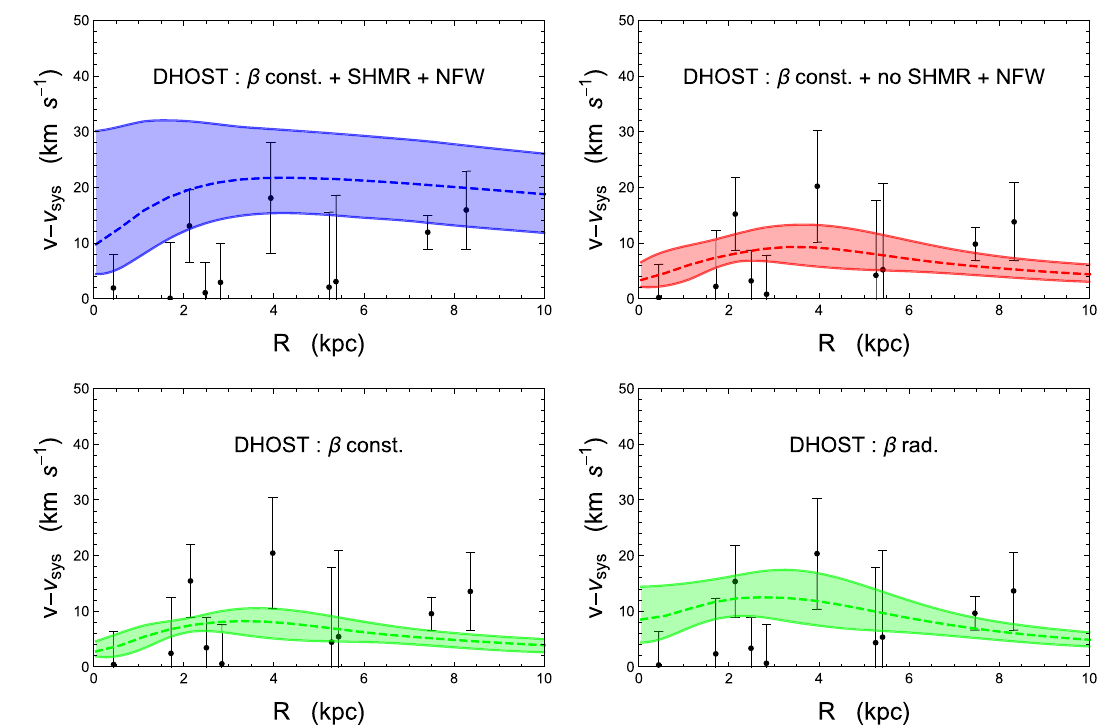
Fig. 3 Velocity offset profiles of NGC1052-DF2 with DHOST. Black dots and bars are observational data, v i − v sys , with uncertainties, σ v Colored dashed line and shaded regions are respectively the median